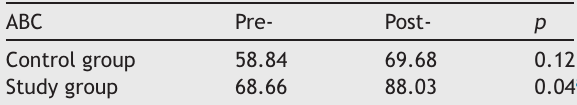
Percent values of means obtained on the Activities-specific Balance Confidence (ABC) scale before and after training by CG and